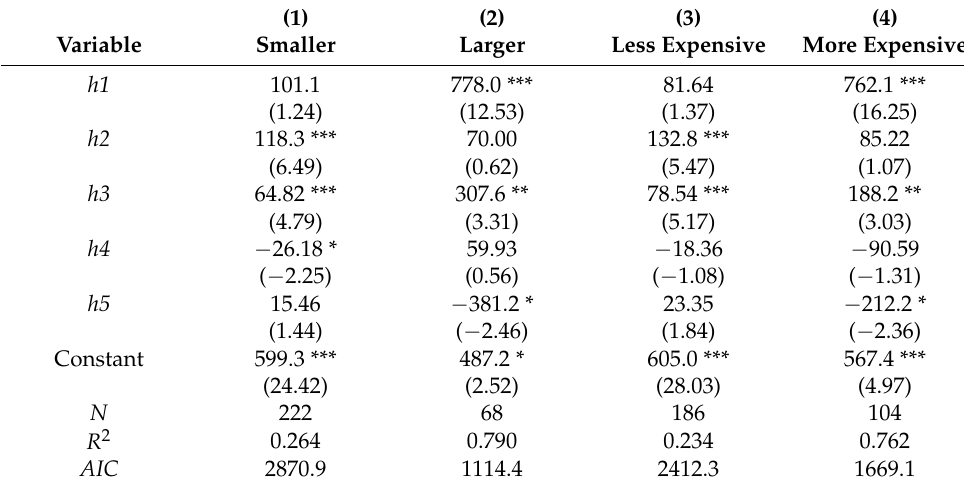
Table 4. Parameter